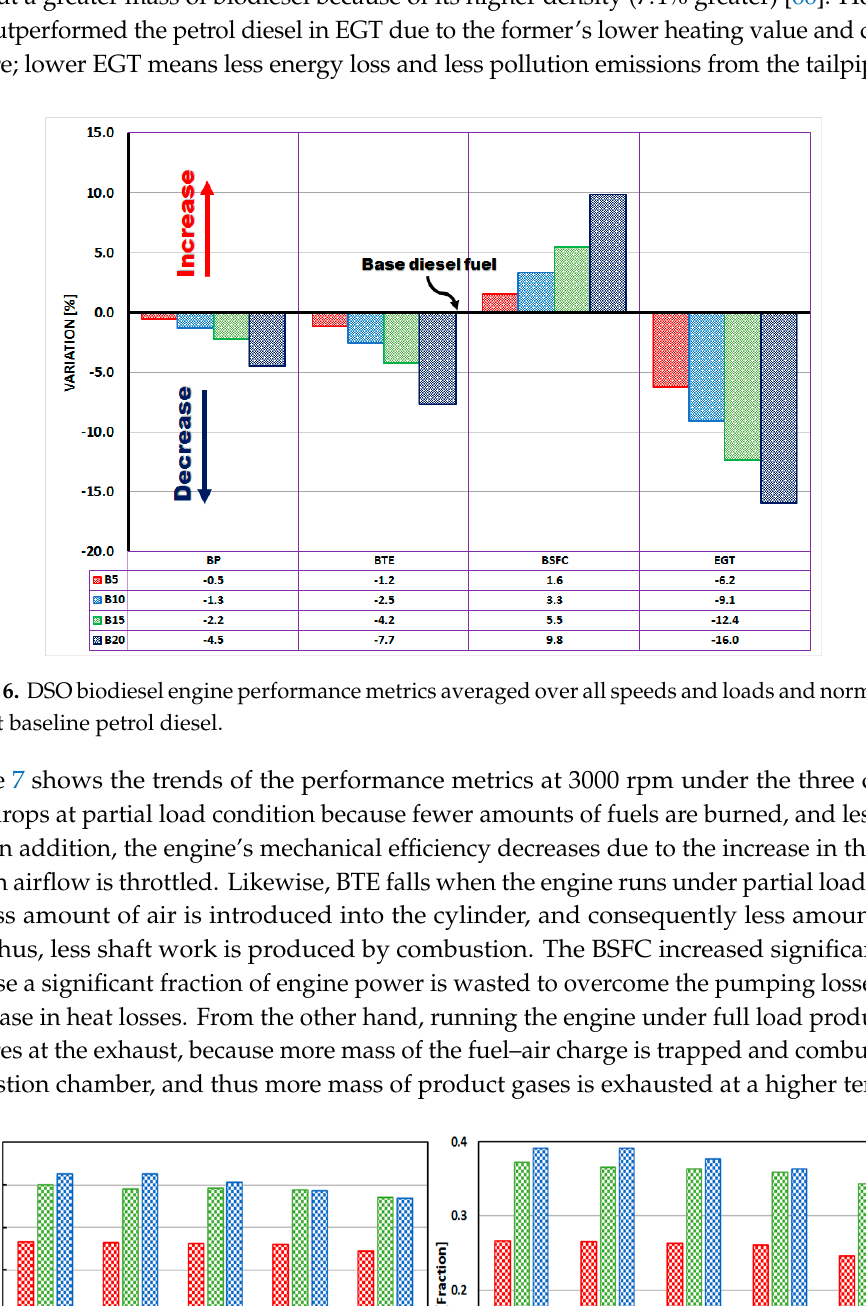
Figure 7. DSO biodiesel engine performance metrics under three loads and 3000 rpm. 3.3. Engine Tailpipe Emissions We averaged the values of the tailpipe emission metrics for the four DSO biodiesel blends over all speeds and loads, then normalized the results against the benchmark petrol diesel (Figure 8). The biodiesel blends emitted progressively less CO pollution with increasing blend %. This relates to the inherent oxygen in the biodiesel’s chemical structure, which promotes complete combustion and reduces the chance for CO formation [68]. In addition, the relatively high CN of the DSO biodiesel (62) results in shorter ignition delay, less opportunity for the formation of fuel-rich spots inside the combustion chamber, and thus less opportunity for CO formation [68]. A similar pattern occurred for CO 2 emissions, again due to the biodiesel’s oxygen content as well as its lower carbon/hydrogen ratio [69]. HC emissions also declined with increasing blend %, primarily due to DSO biodiesel’s higher CN and thus shorter ignition delay and less chance for the air–fuel mixture to be diluted by more air before autoignition occurrence. Thus, it is improbable to have local mixtures that are lean to levels less than the flammability limits, causing misfires that release hydrocarbons outside the combustion chamber. In contrast, NO x emissions increased slightly (<4%) with increasing blend %, possibly due to the oxygen content of the DSO biodiesel because this promotes complete combustion and higher temperatures in the combustion chamber, a main contributor to NO x formation [70]. The higher CN of the blends is another contributing factor because this produces shorter ignition delays and thus advanced combustion that increases NO x emissions [71].